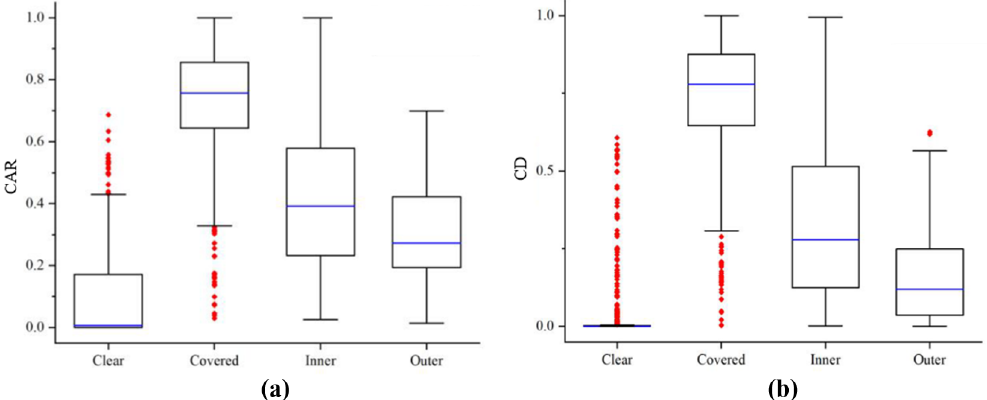
Figure 7. Distribution of feature value for each type of ASC image. (a) Distribution of CAR and (b) distribution of CD.